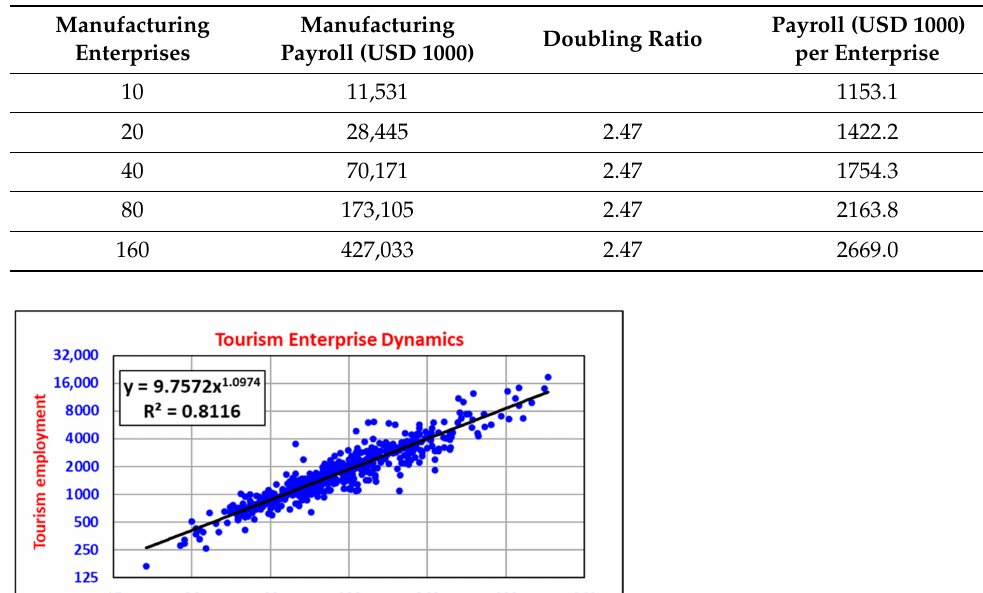
Table 5. Manufacturing payrolls in relation to the number of manufacturers in United States microp- olitans. The power law in Figure 6 was used in the calculations.